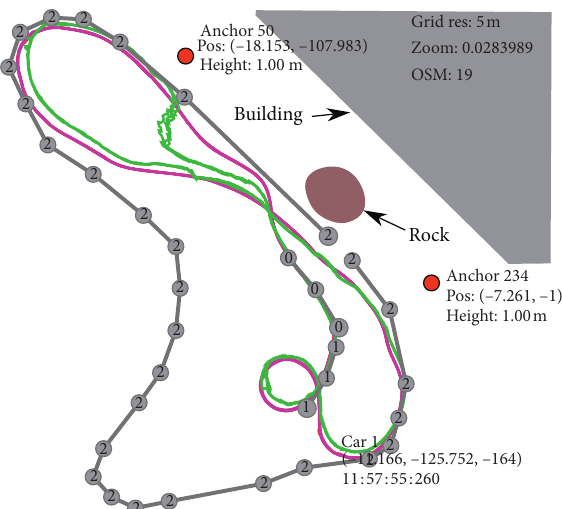
Figure 18: Experiment on parking lot with rock without FI, re- peated three times. The traces for the repetitions are overlayed, and mostly overlapping, maximum UWB deviation: 2 m.